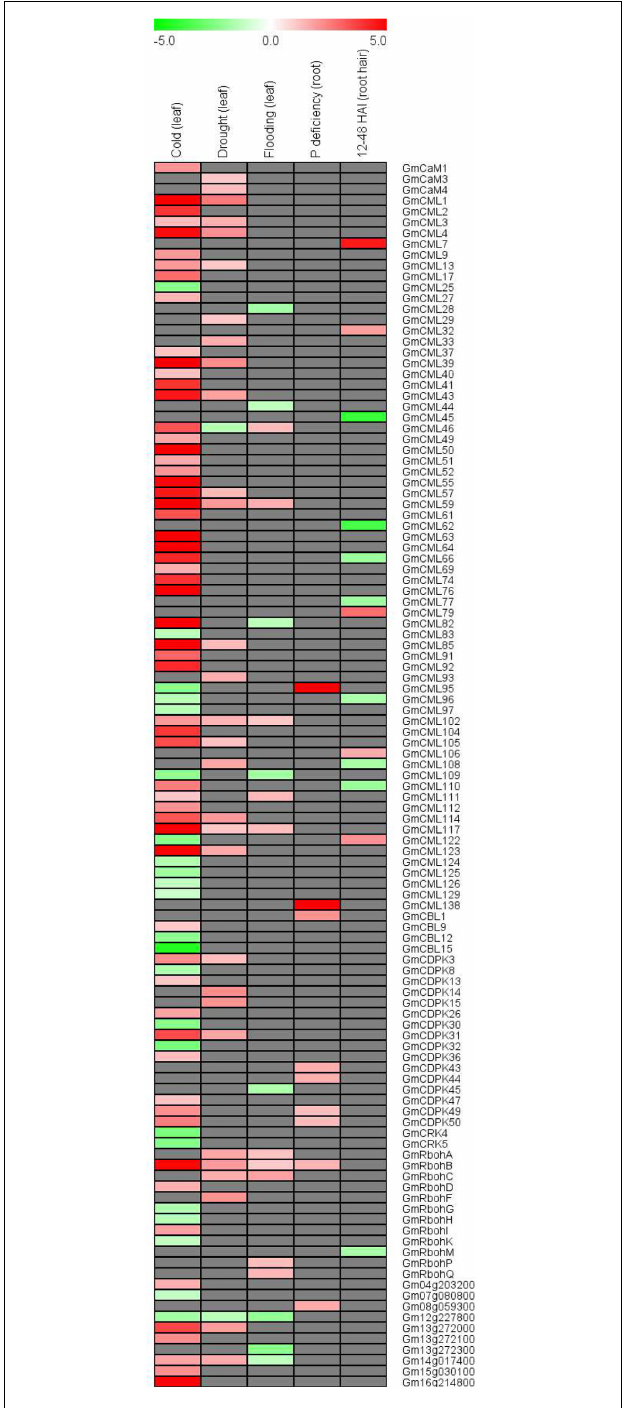
FIGURE 11 | Heatmap representation for expression profiles of EF-hand protein-encoding genes in response to cold, drought, flooding, phosphorus deficiency, and Bradyrhizobium japonicum inoculation (24–48 HAI). The intensities of the color represent the relative magnitude of fold changes in log2 values according to microarray or high-throughput sequencing data. Red color indicates induction, green color indicates repression, gray color means there is no significant expressional